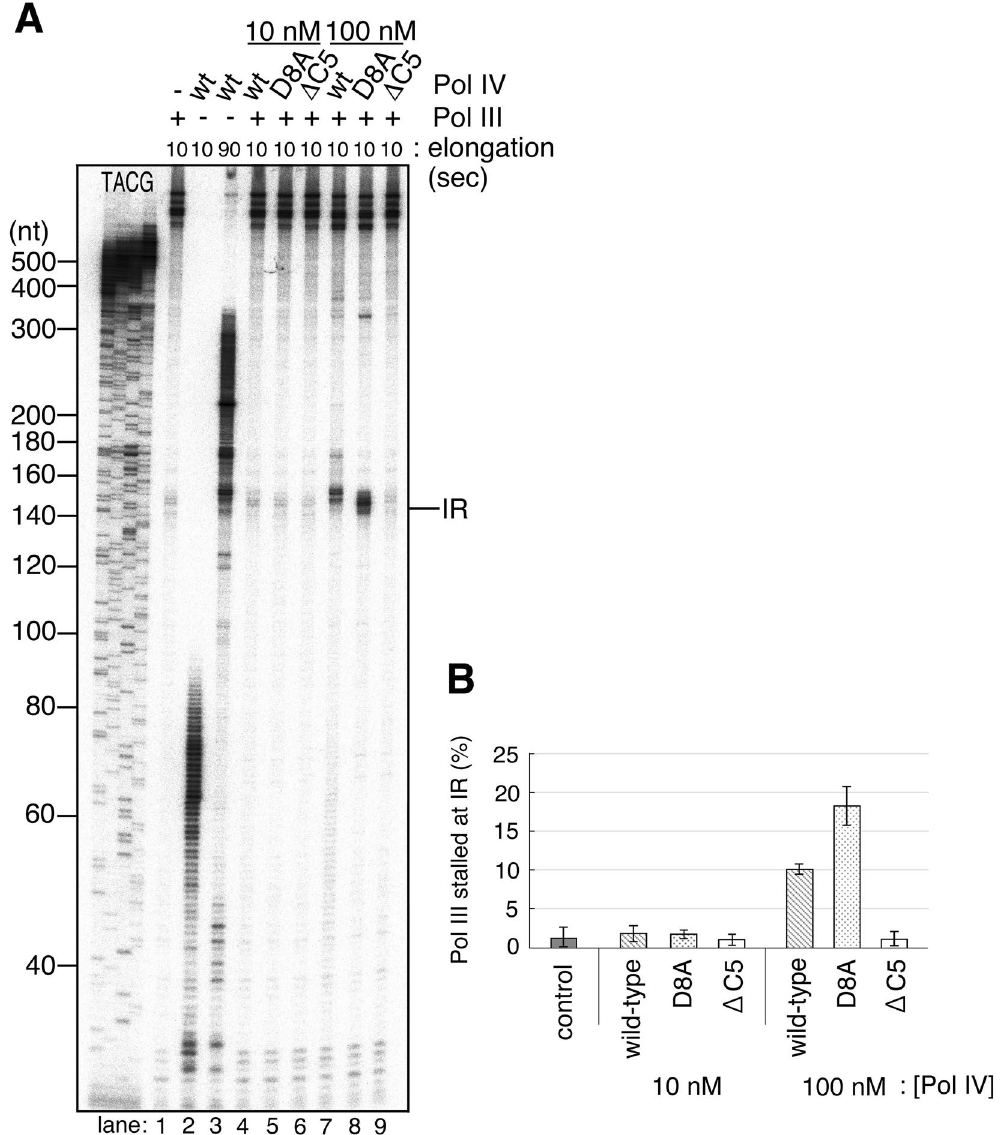
Figure 4. Pol III-Pol IV switch takes place when elongating Pol III collides with a hairpin structure on template ssDNA. ( A ) The effect of Pol IV on ongoing Pol III was tested on primed pMS2-aIR-23. Wild-type Pol IV or mutant Pol IV (D8A, Δ C5) was added to the reaction mixture (at a final concentration of 10 or 100 nM) together with dTTP when the elongation reaction started, and replication products at indicated time points were analyzed as in Fig. 2B. ( B ) The effect of wild-type or mutant Pol IV on ongoing Pol III at the repeat was quantitatively analyzed. The amount of pausing products at the repeat (between ~140 nt and ~191 nt) relative to the amount of total products in Fig. 4A were quantified and the percentages of stalled Pol III at the repeat were calculated. The average percentages of three independent experiments were shown with